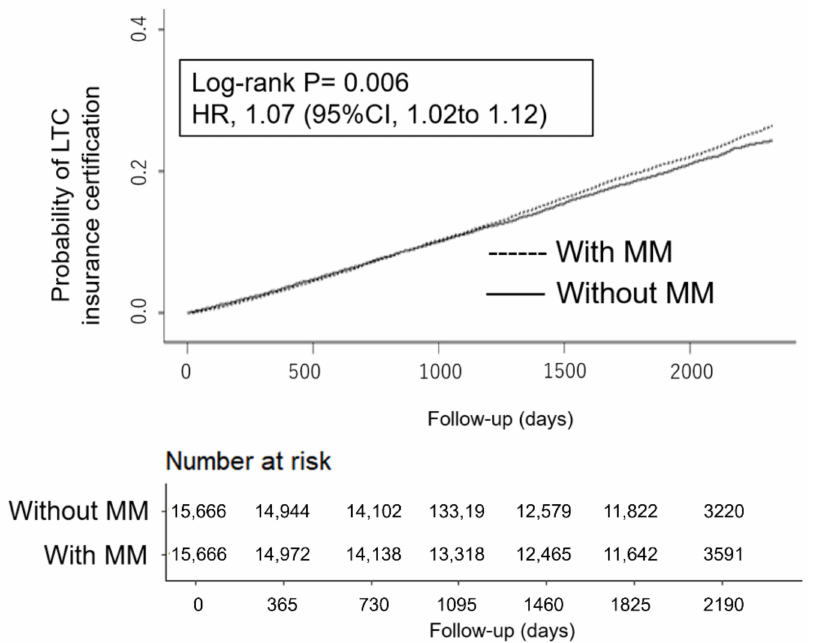
Figure 2. Cumulative incidence curve for overall care needs between patients with the MM group and patients without the MM group. Confidence interval (CI), hazard ratio; long-term care (LTC); multimorbidity